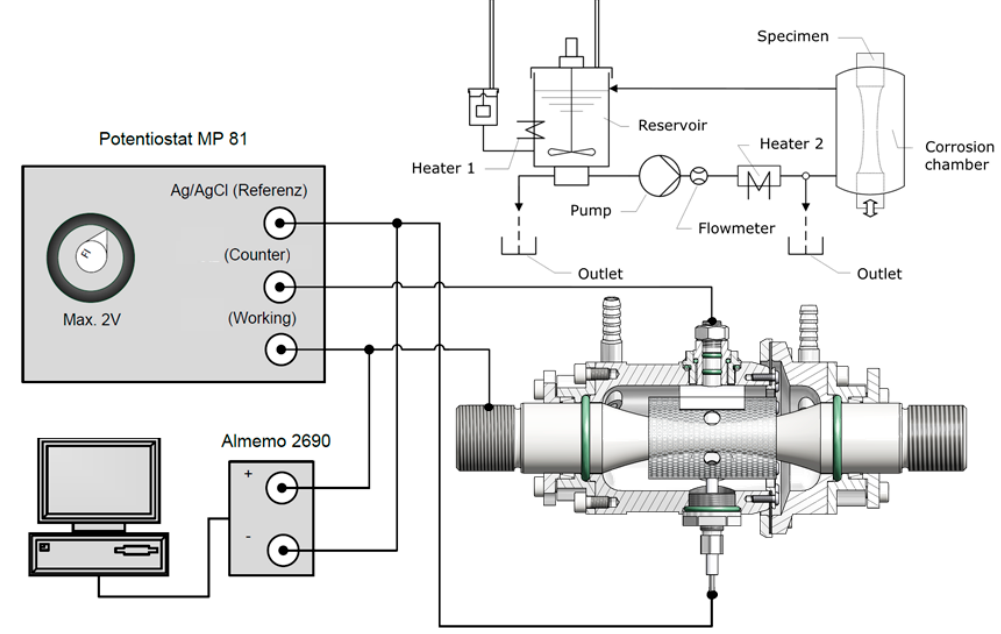
Figure 1. Schematic setup of in situ corrosion fatigue testing.